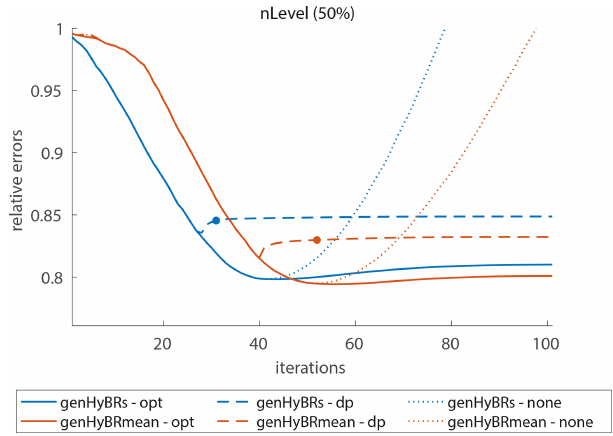
Figure 6. One-year case study: for 50% noise level, we provide relative reconstruction error norms per iteration of genHyBRs and genHyBRmean and compare results for the optimal regularization parameter, the automatically selected DP parameter, and λ =